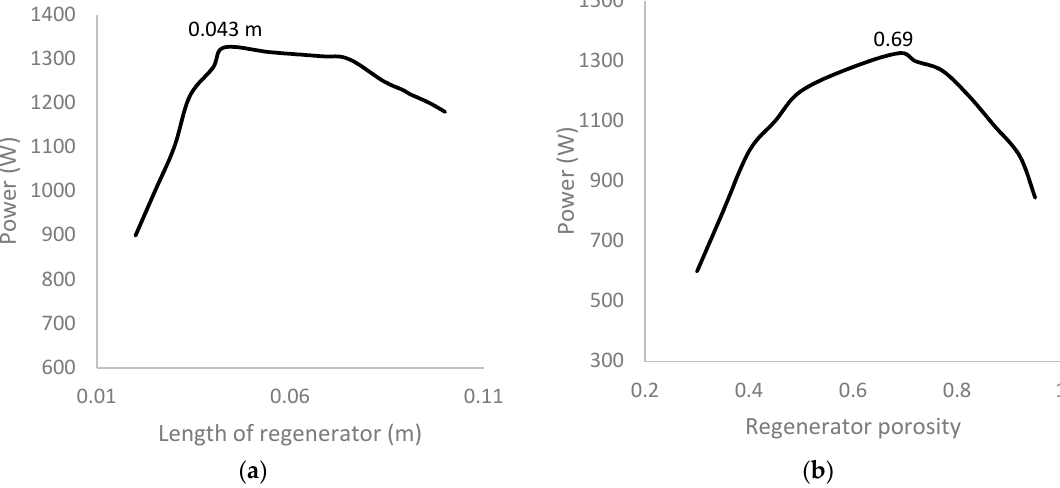
Figure 7. ( a ) Indicated power vs. length of regenerator; ( b ) Indicated power vs. regenerator porosity.